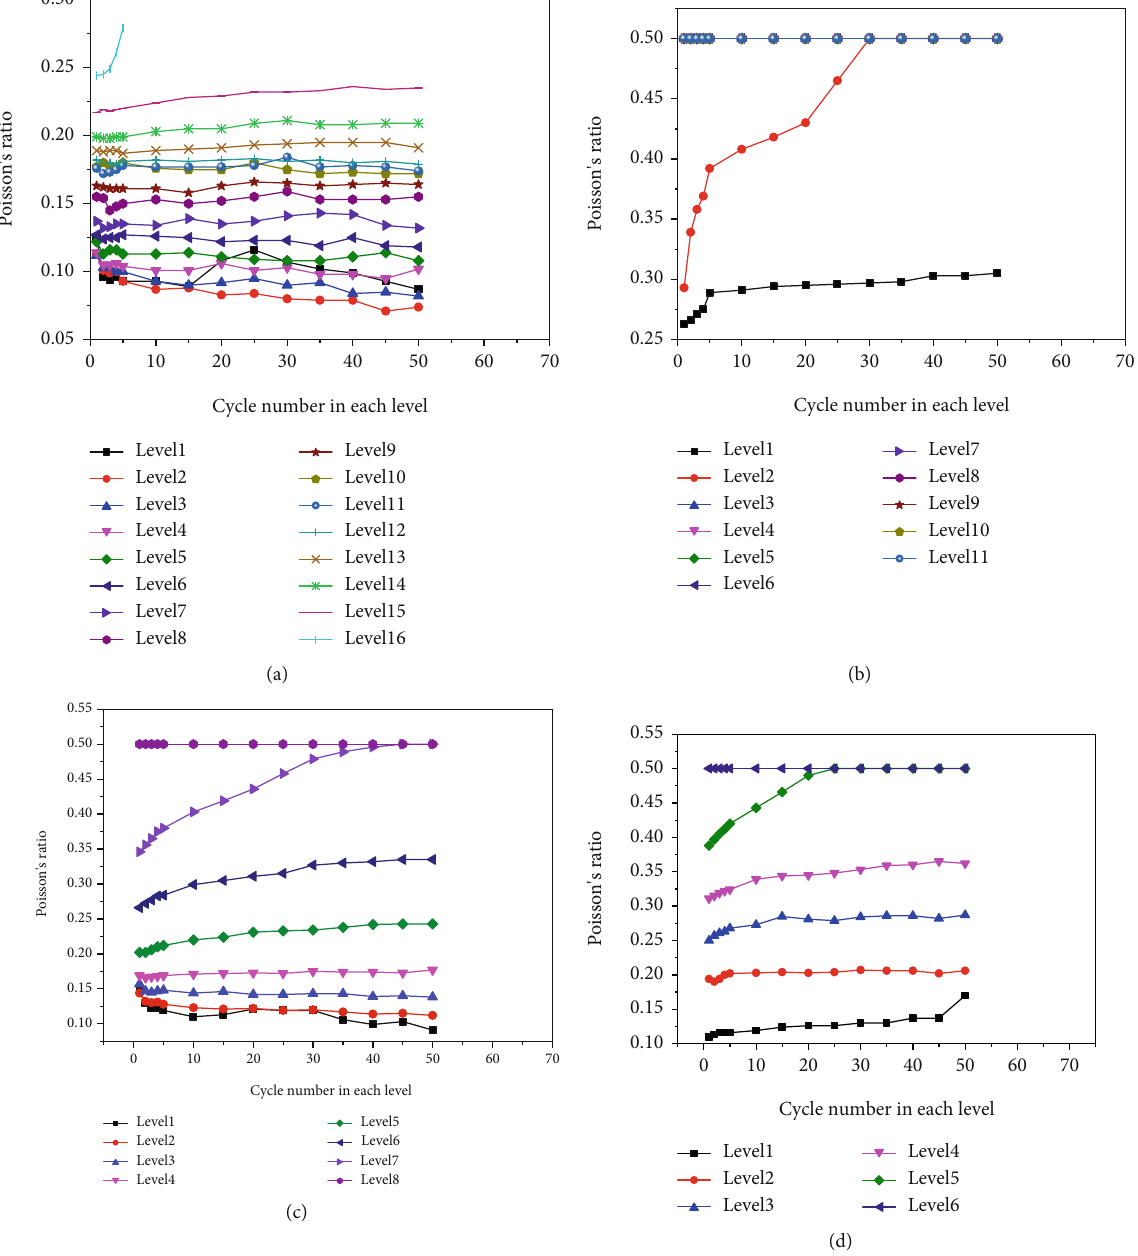
Figure 4: Evolution of Poisson ’ s ratio with cyclic number at various cyclic levels ((a – d) the initial natural fracture volume ratio is 0.68%, 1.03%, 1.53%, and 2.27%,